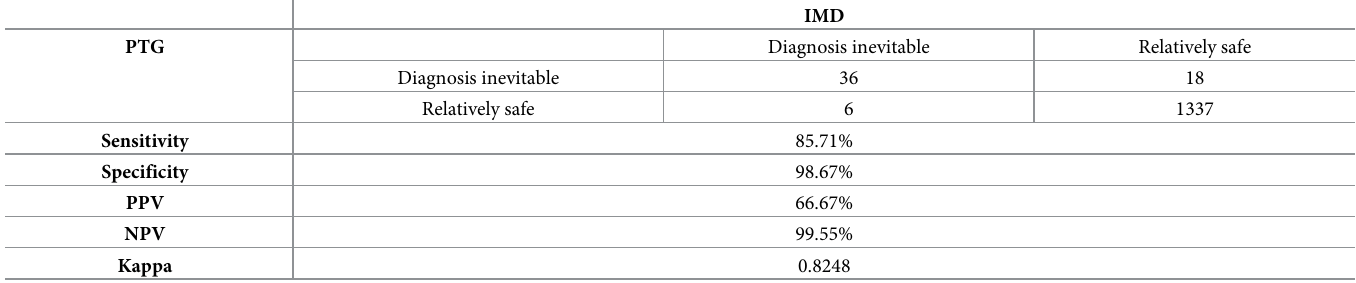
Table 4. The concordance of pseudo-tetraploid genotyping (PTG) with the invasive molecular diagnosis (IMD) (the current gold standard) on the necessity of inva- sive prenatal diagnosis.